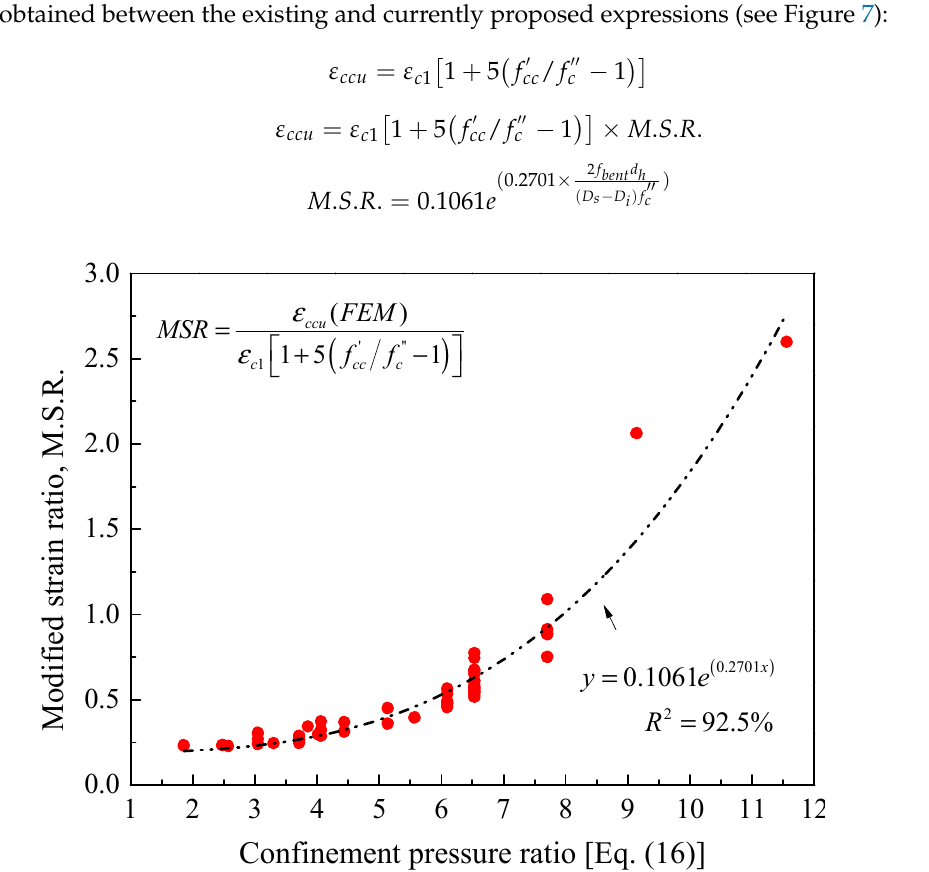
Figure 7. Correlation between the present confined strain model and that proposed by Mander et al. [92] for confined concrete.